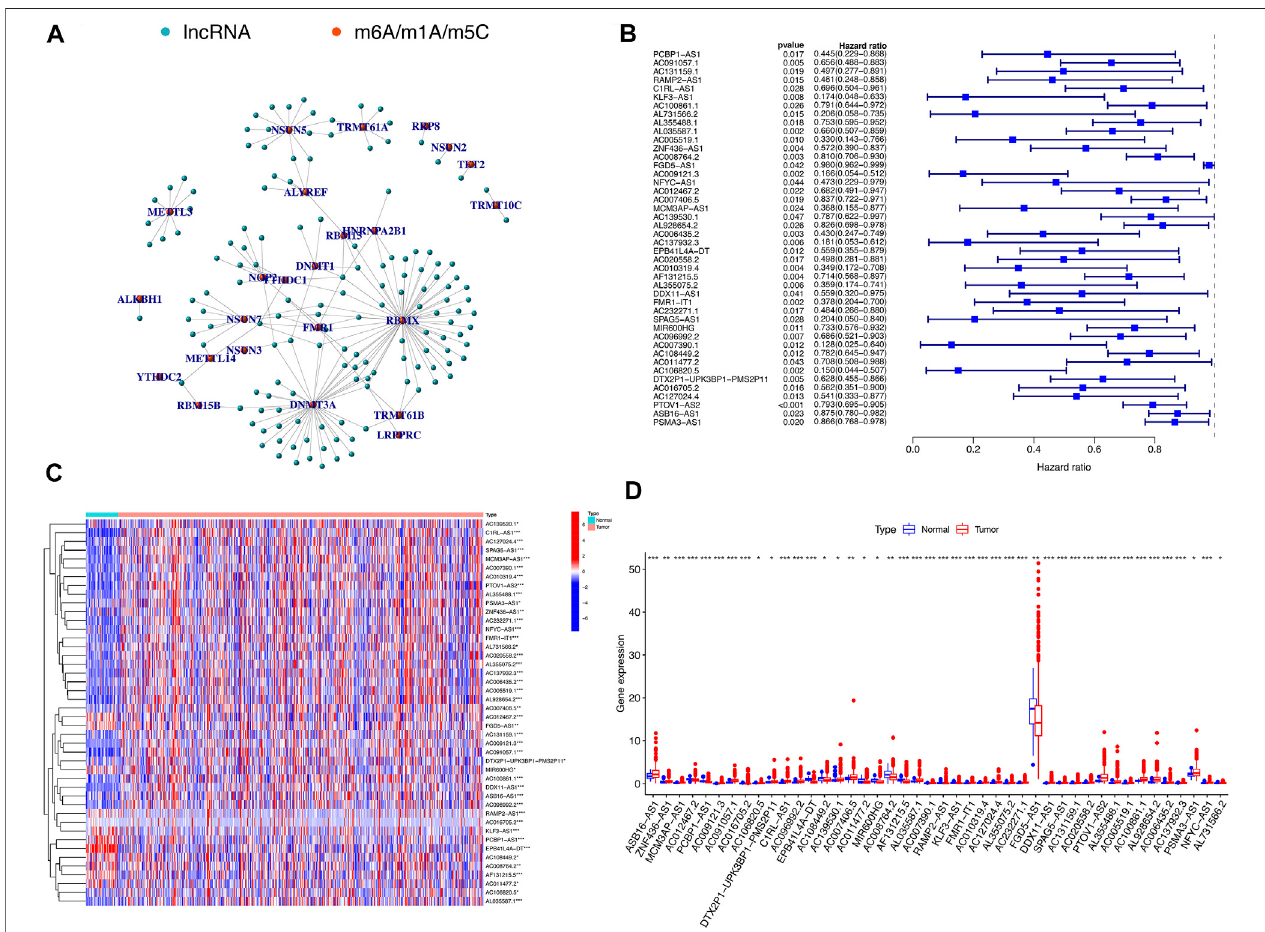
FIGURE 2 | m 6 A/m 5 C/m 1 A-related mRNA – lncRNA co-expression network and identi fi cation of prognostic value of m 6 A/m 5 C/m 1 A-related lncRNAs. (A) 147 lncRNAs co-expressed with m 6 A/m 5 C/m 1 A-related genes. Green represents lncRNAs, while red represents m 6 A/m 5 C/m 1 A-related genes. (B) The forest plot of univariateCoxregressionshowedthat44lncRNAswithprognosticvaluewereprotectivefactorsofHNSCC. (C,D) Theheatmapandboxplotofdifferentialexpressionof 44 lncRNAs with prognostic value between 44 normal tissues and 501 tumor tissues in TCGA-HNSCC database.